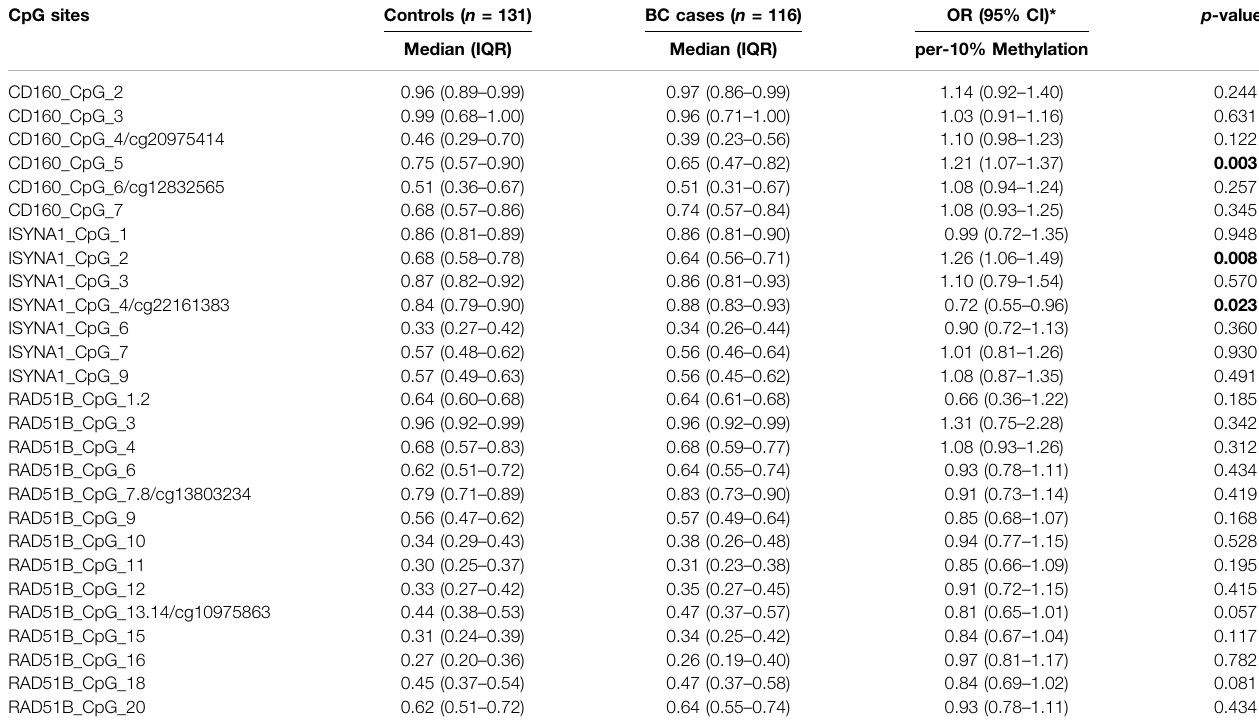
TABLE 2 | Association between blood-based methylation of CD160 , ISYNA1 , and RAD51B and BC in subjects younger than 45 years old combining validation I and validation II. CpG sites Controls ( n =